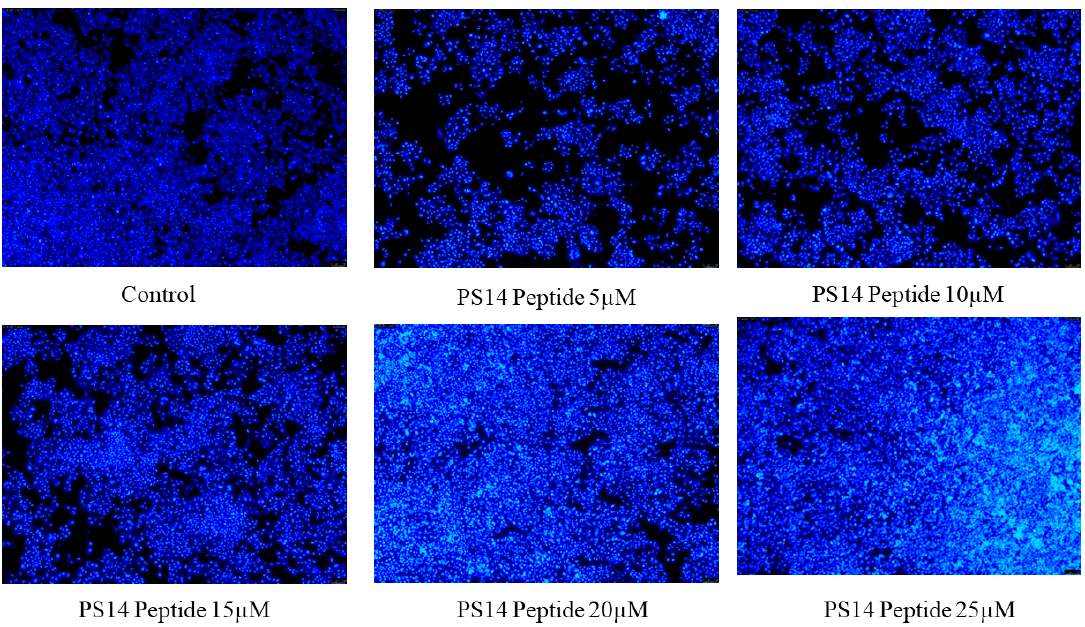
Figure 5. The Hoechst 33342 staining detected apoptotic induction in PS14-treated Hep-2 cells. The apoptotic cells were observed as high intensity of bright blue. No apoptotic induction was observed in the untreated control.